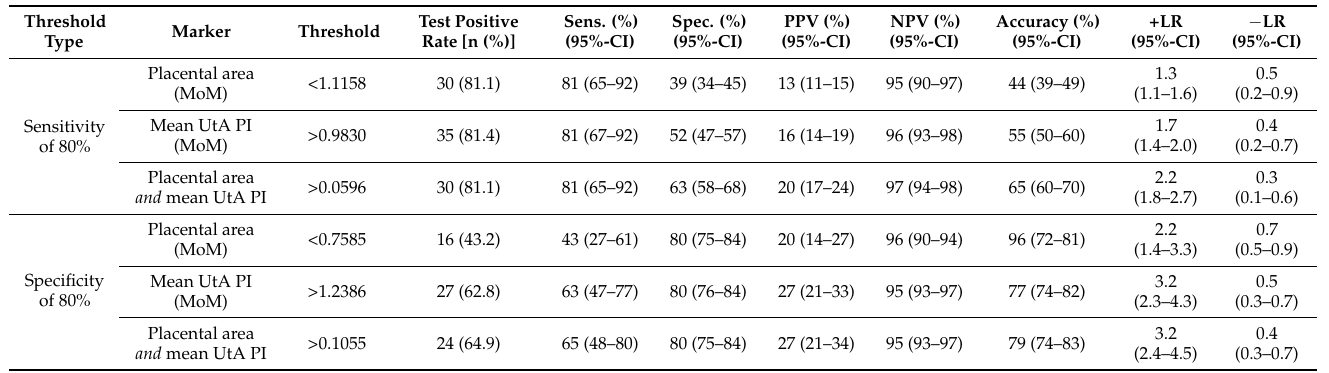
Table 4. Predictive accuracy of placental area and uterine artery for the primary outcome.